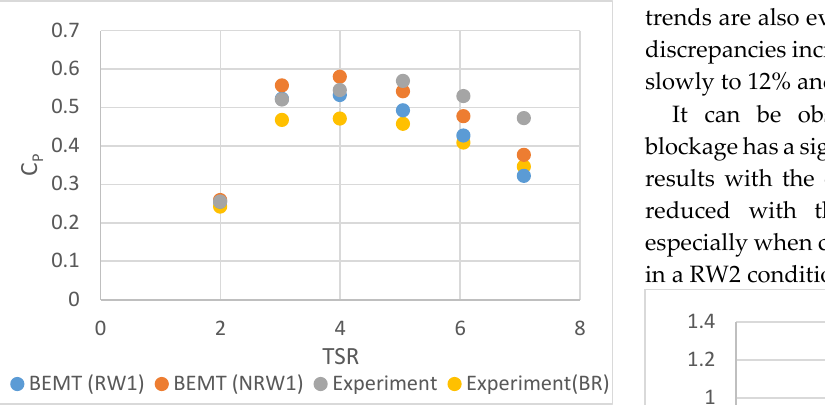
Figure 10. C P comparison between BEMT calculations and experimental data for the inflow profiles with and without a turbine when the turbine operates under wave-current interactions with a wave height of approximately 0.19m and an apparent wave period of 0.7s.